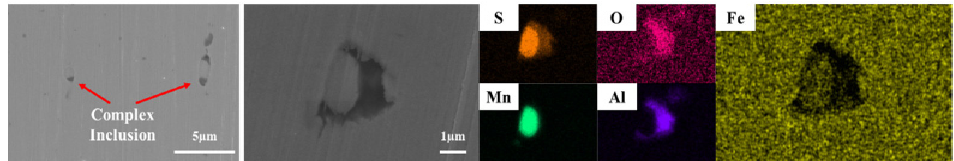
Figure 1. Morphology and composition of inclusions in